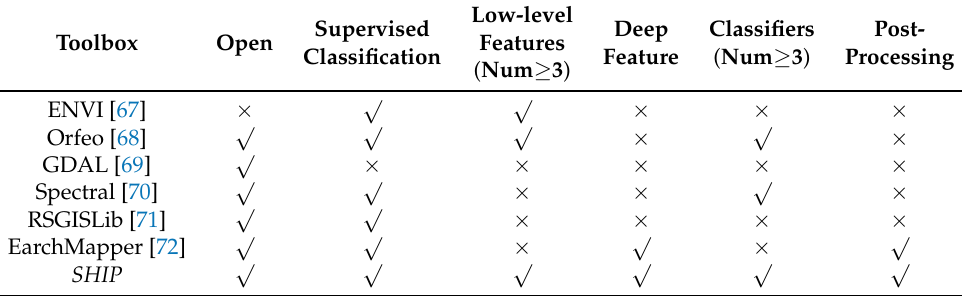
Table 1. Comparison of different Hyperspectral image (HSI) analysis tool-boxes.